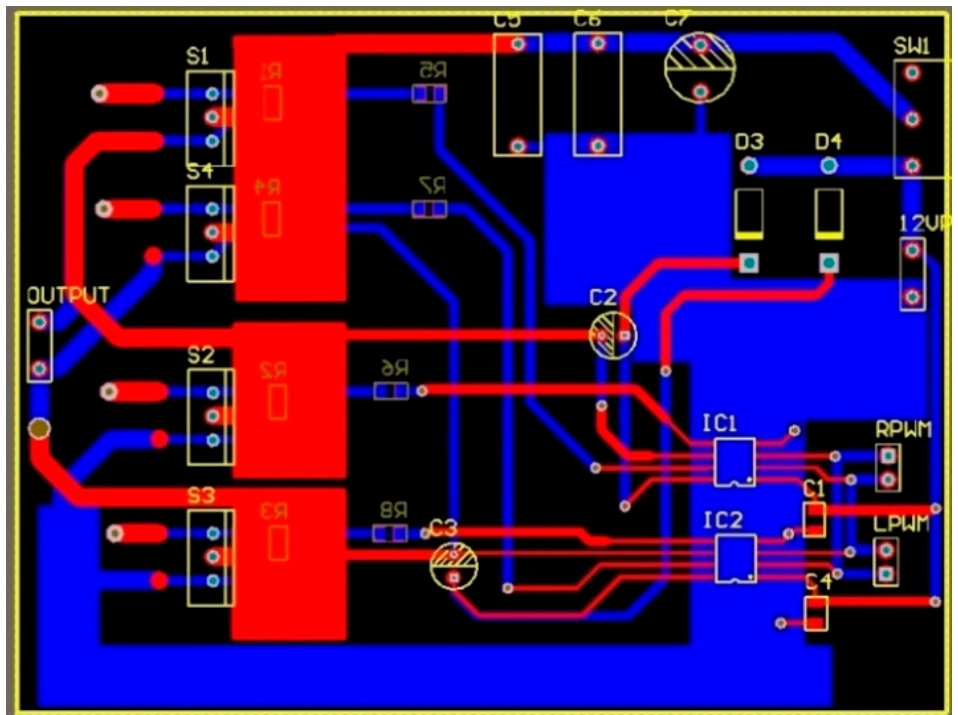
Figure 5. PCB (Printed Circuit Board ) layout of the motor drive circuit.